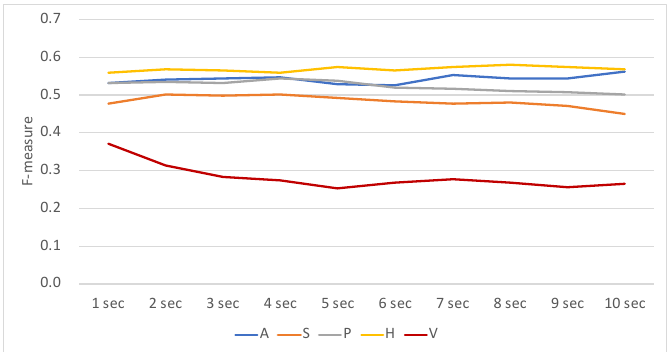
Figure 5. F-measure values (shown as the vertical axis) of each feature set in idling model according to window size from 1 to 10